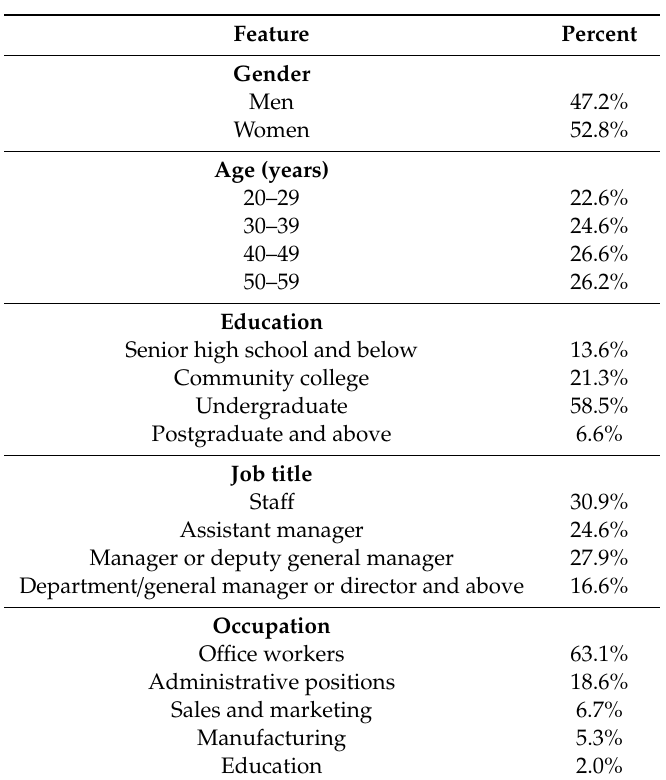
Table 1. Demographic